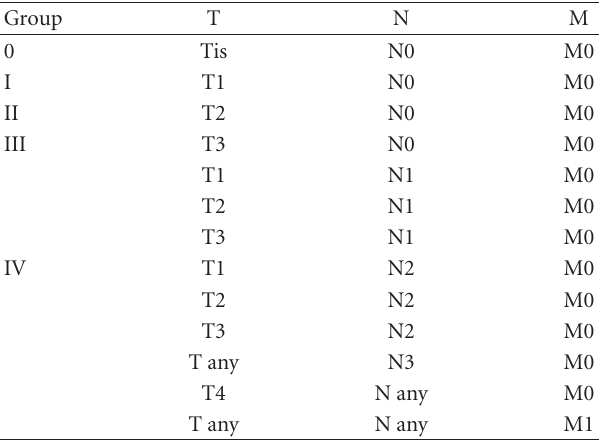
Table 3: AJCC Prognostic groups based on TNM staging